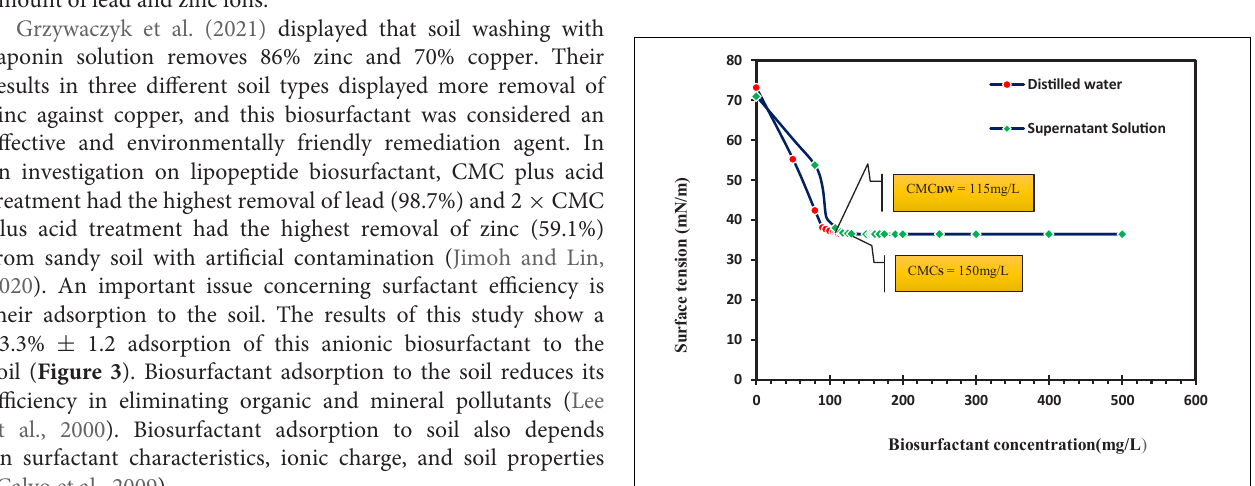
FIGURE 3 | Adsorption of biosurfactant to contaminated soil at different biosurfactant concentrations, CMC DW , critical micelle concentration measured in distilled water; CMC S , the measured critical micelle concentration of supernatant solutions [supernatant solutions obtained by centrifugation of a mixture of biosurfactants (at different concentrations) and